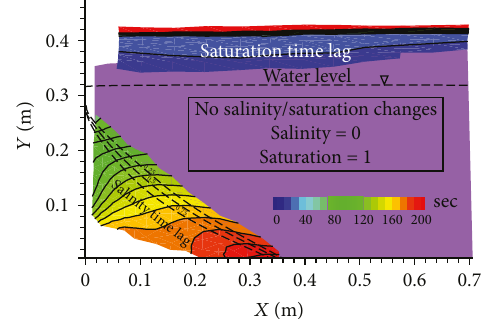
Figure 9: Time lags calculated using cross-correlation of saturation and salinity behind the sea level. Water level and contours of salinity as fraction from seawater salinity are shown for